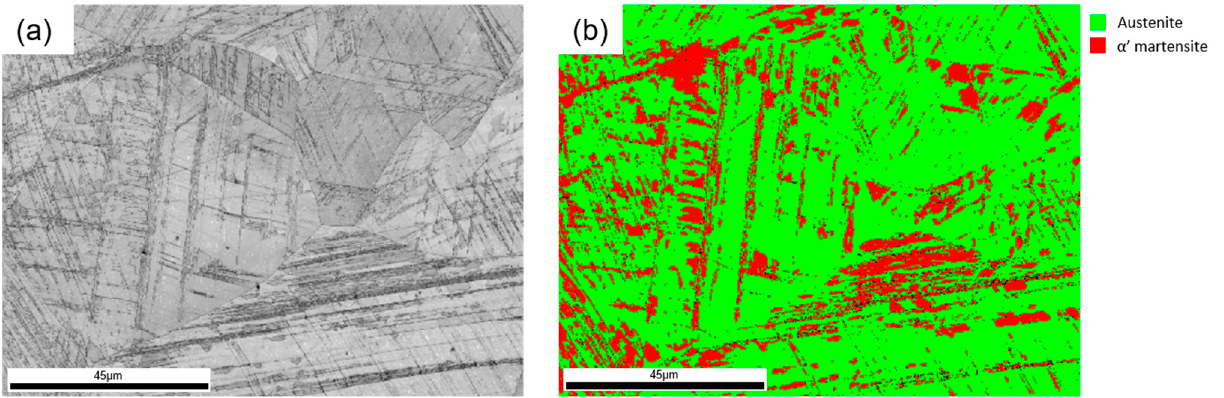
Figure 4. ( a ) Image quality map obtained from half thickness region of the cold formed reactor by using electron back scattered diffraction (EBSD) analysis and ( b ) phase map of the region ( a